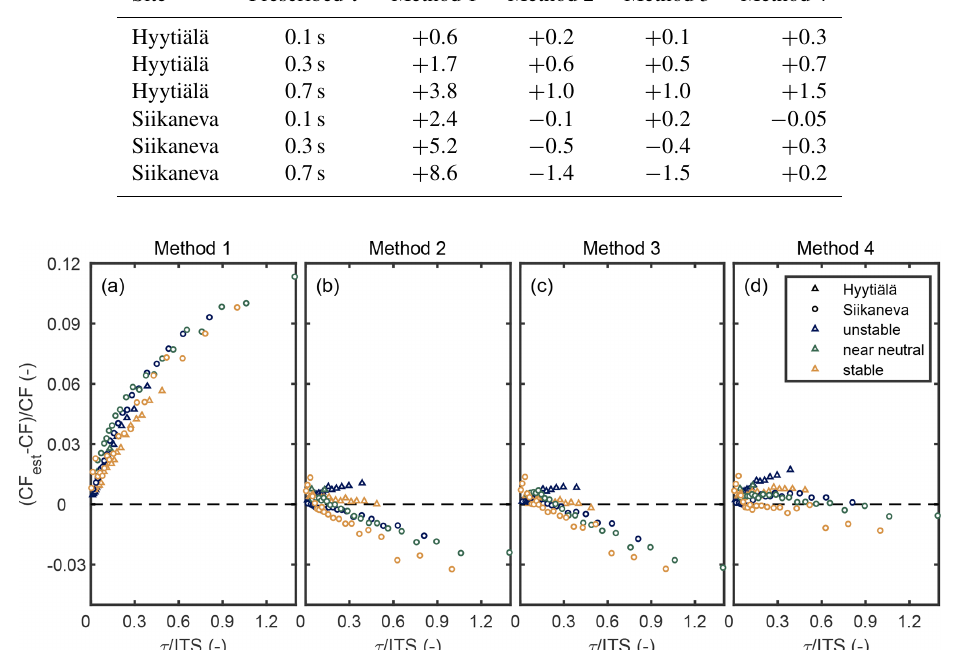
Figure 6. Relative bias in the estimated correction factor (CF est ) against τ/ ITS, where ITS is the integral timescale of w (cid:48) T (cid:48) . Data were divided into unstable ( ζ < − 0 . 1), stable ( ζ > 0 . 1) and near-neutral ( | ζ | < 0 . 1) cases before bin-averaging and plotting. Reference values for the correction factor (CF in the figure) were calculated from the ratio between unattenuated and attenuated covariances. Note that the different colours refer to different stability conditions and markers to the different